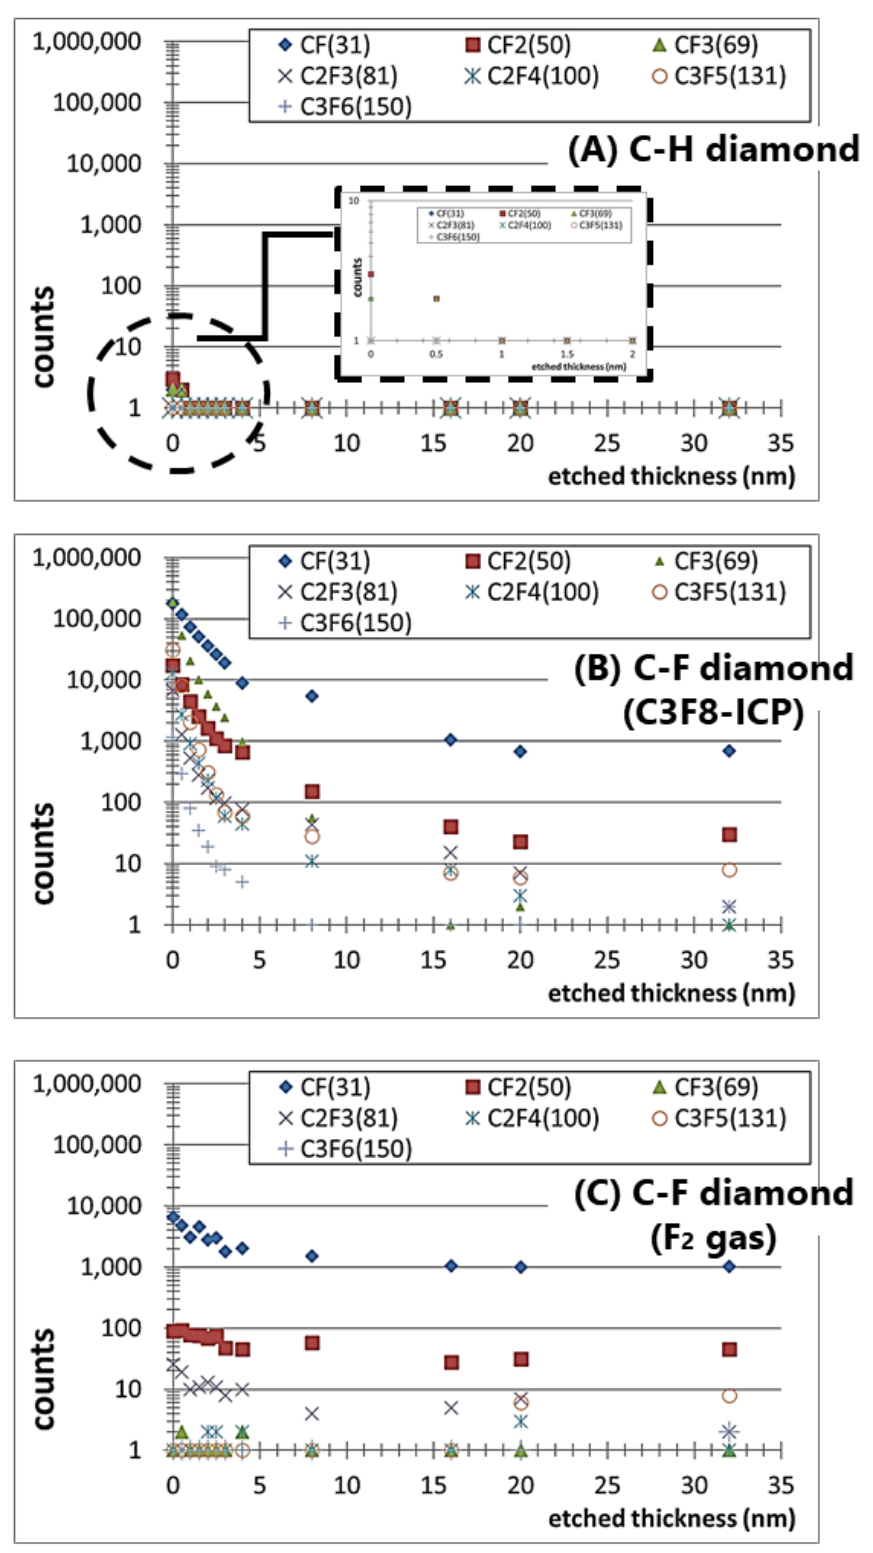
Figure 5. The ratio of fluorine-related fragments as measured by TOF-SIMS analysis: ( A ) C–H diamond; ( B ) perfluoropropane–ICP(C 3 F 8 -ICP)-treated C–F diamond; and ( C ) fluorine-gas(F 2 -gas)- treated C–F diamond.